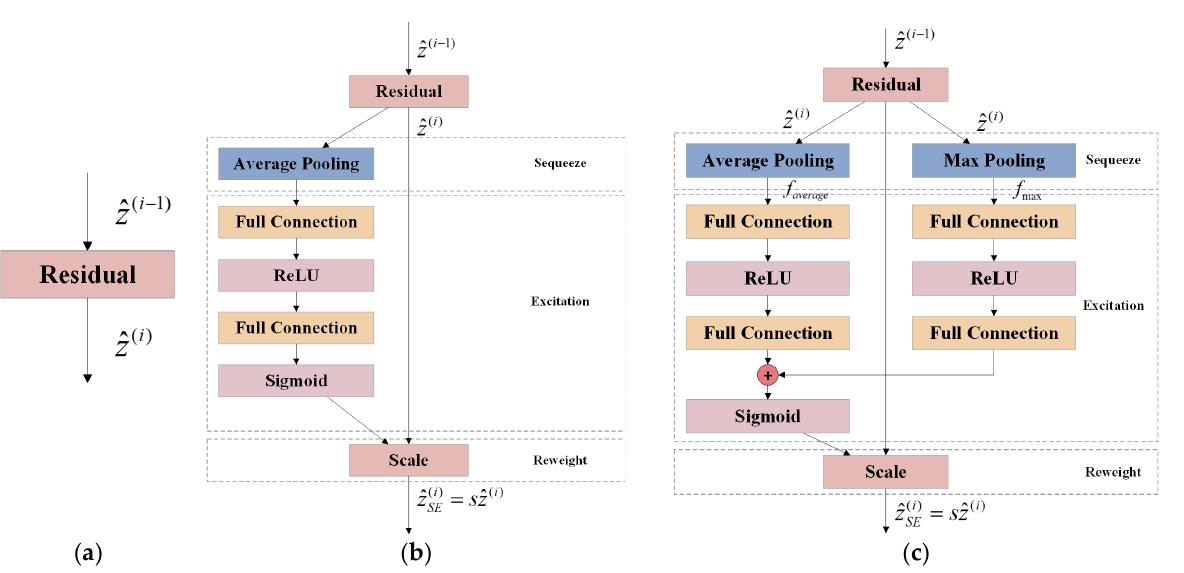
Figure 7. The comparison of TCN residual block and SE-TCN residual block. ( a ) TCN residual block; ( b ) SE-TCN residual block with average pooling; ( c ) SE-TCN residual block with average pooling and max pooling.